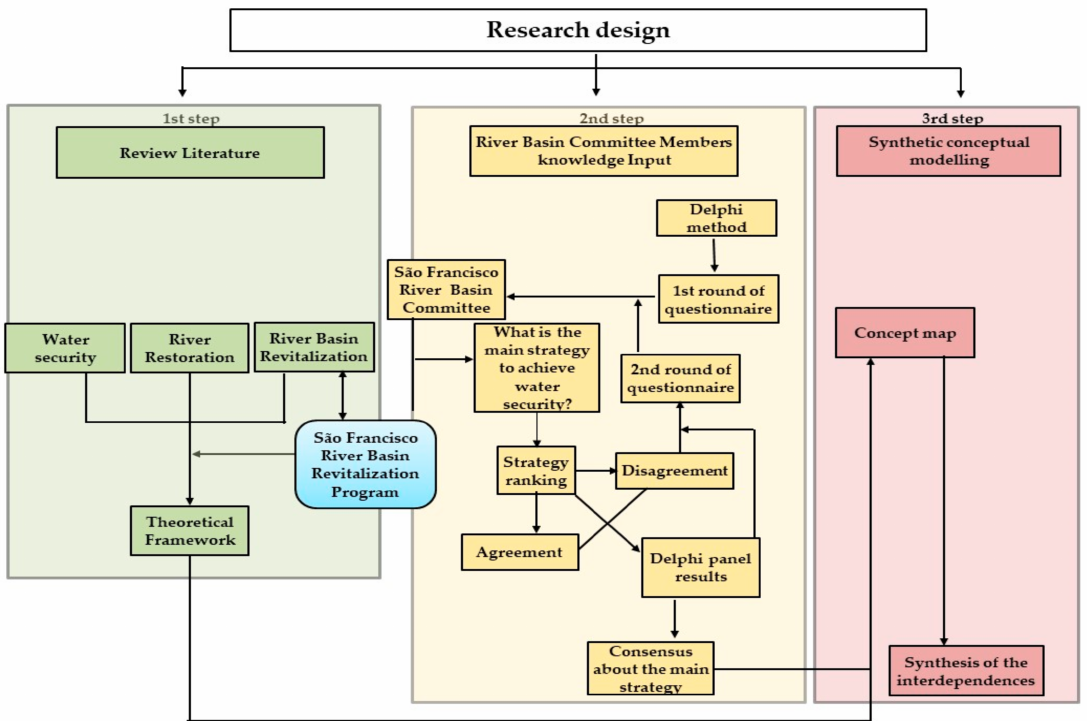
Figure 1. Research method design synthesis